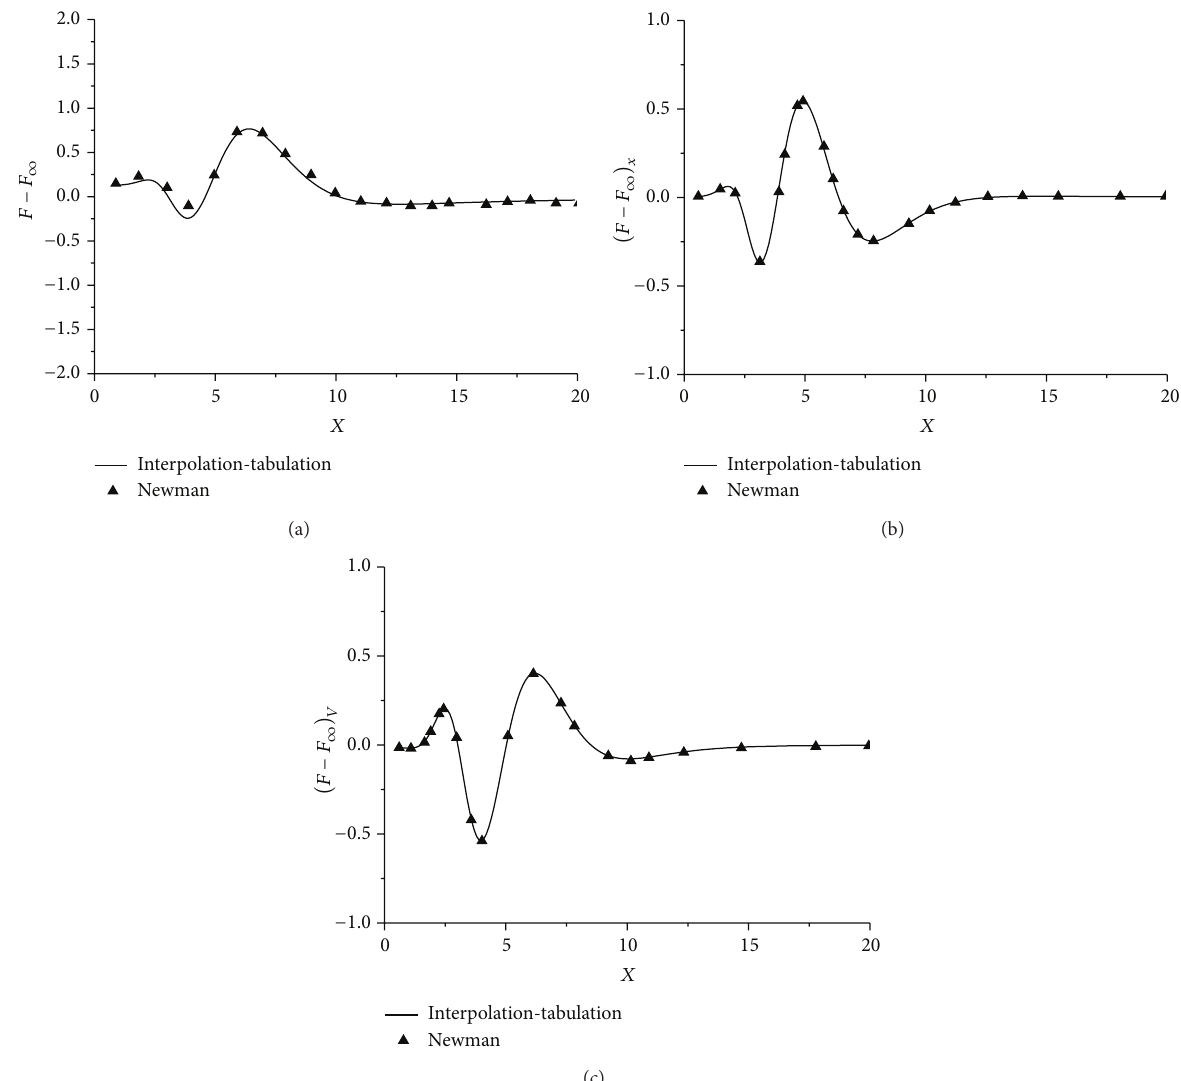
Figure 6: Comparison of 𝐹 − 𝐹 ∞ , (𝐹 − 𝐹 ∞ ) 𝑋 , and (𝐹 − 𝐹 ∞ ) 𝑉 by the interpolation-tabulation method with